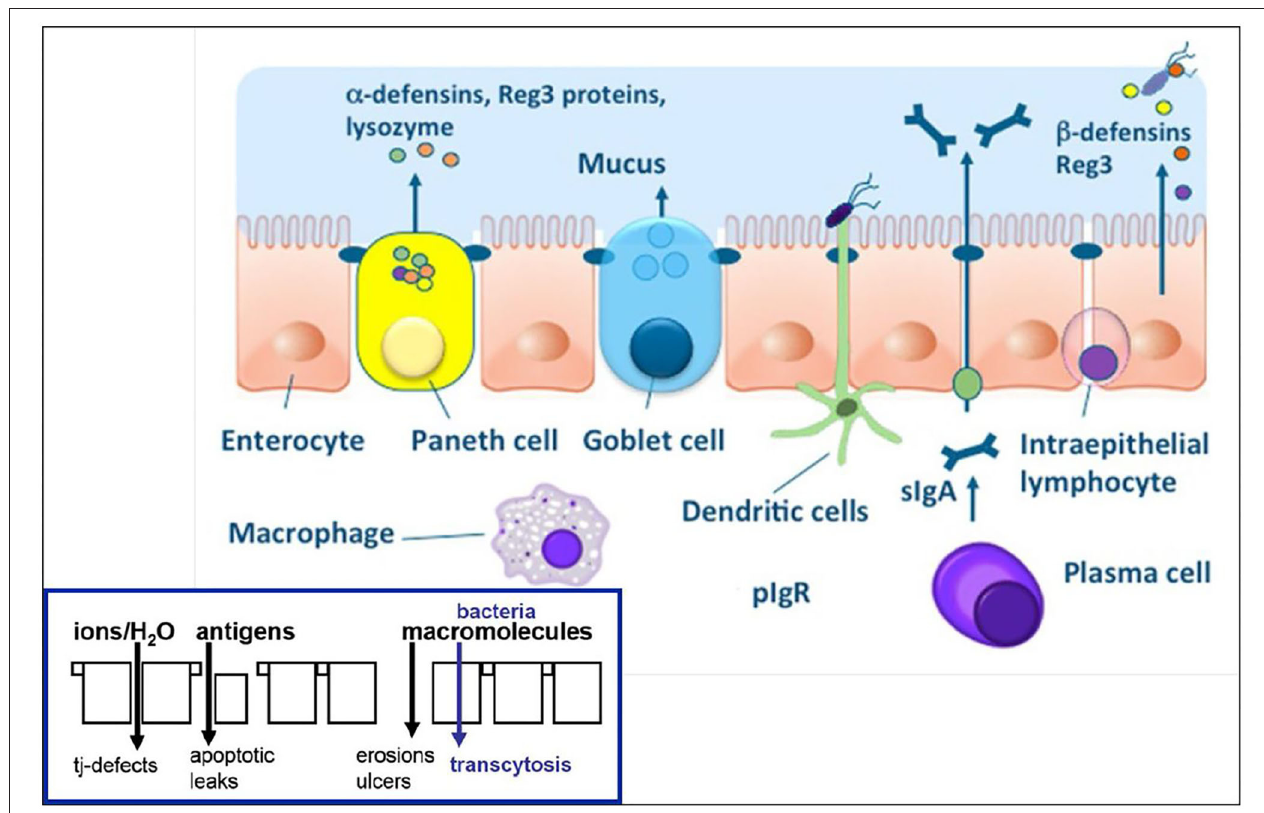
FIGURE 1 | Physical and chemical components of the intestinal epithelial barrier. See text for component specifics. With epithelial barrier dysfunction (insert), intestinal permeability increases which allows for antigens and macromolecules (bacteria) to pass into the lamina propria where innate and acquired immune cells reside. From: ( 14) with